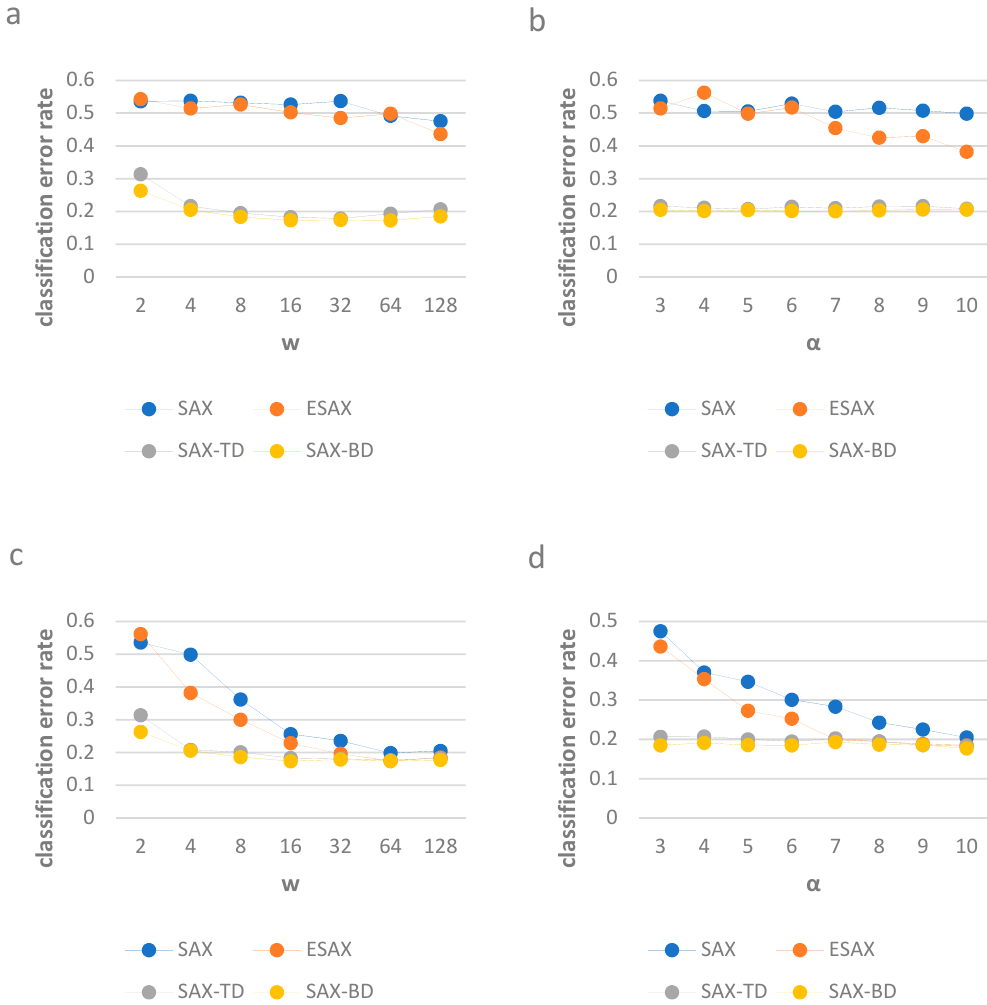
Figure 7. The classification error rates of SAX, ESAX, SAX-TD and SAX-BD with di ff erent parameters w and α . For ( a ), on Gun-Point, w varies while α is fixed at 3, for ( b ), on Gun-Point, varies while w is fixed at 4. For ( c ), on Yoga, w varies while α is fixed at 10, for ( d ), on Yoga, varies while w is fixed at 128.